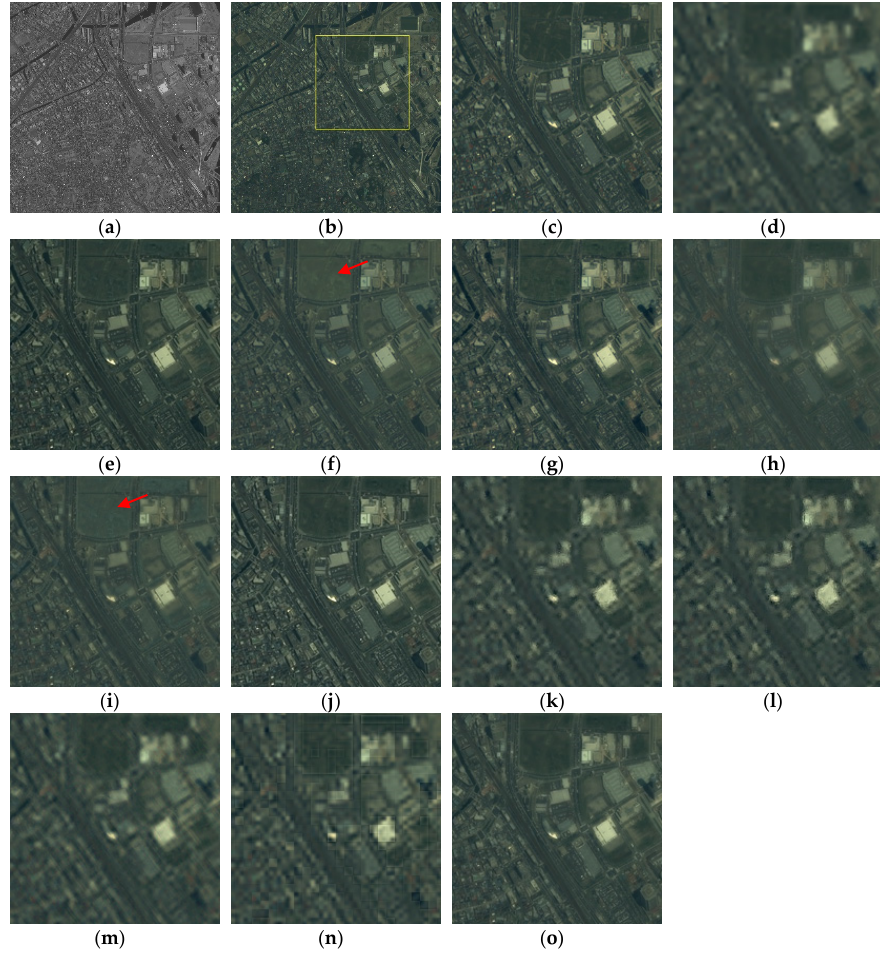
Figure 8. Reference and pansharpened Yokohama images: ( a ) original PAN image (reference image), ( b ) original RGB image, ( c ) ground truth RGB image, ( d ) RGB image upsampled by bicubic interpolation, ( e ) fast IHS, ( f ) GS, ( g ) BDSD, ( h ) WLS, ( i ) MDSIm, ( j ) SCMP, ( k ) ISSR (natural images were used for training), ( l ) ISSR (Yokohama images were used for training), ( m ) SR-D, ( n ) SRayas method, ( o ) proposed method ( τ = 0.4 )